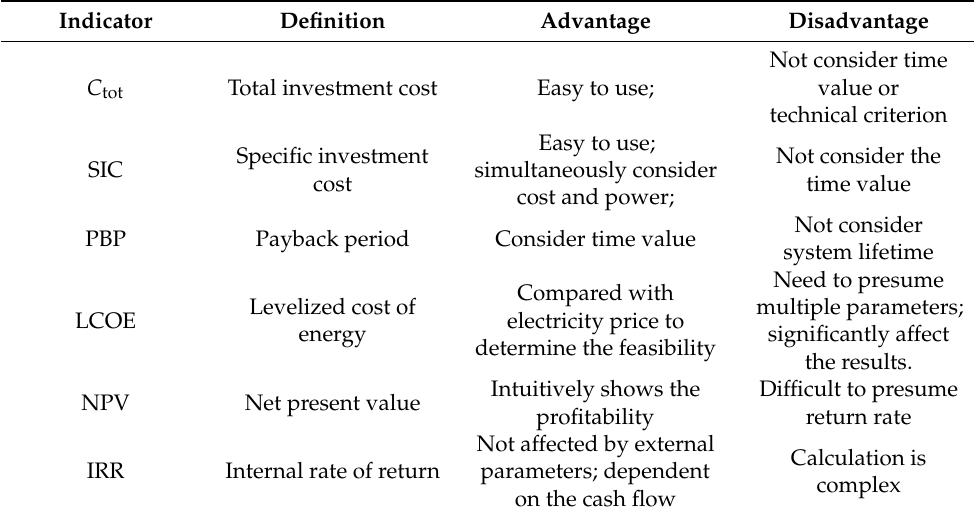
Table 1. Comparison of different economic